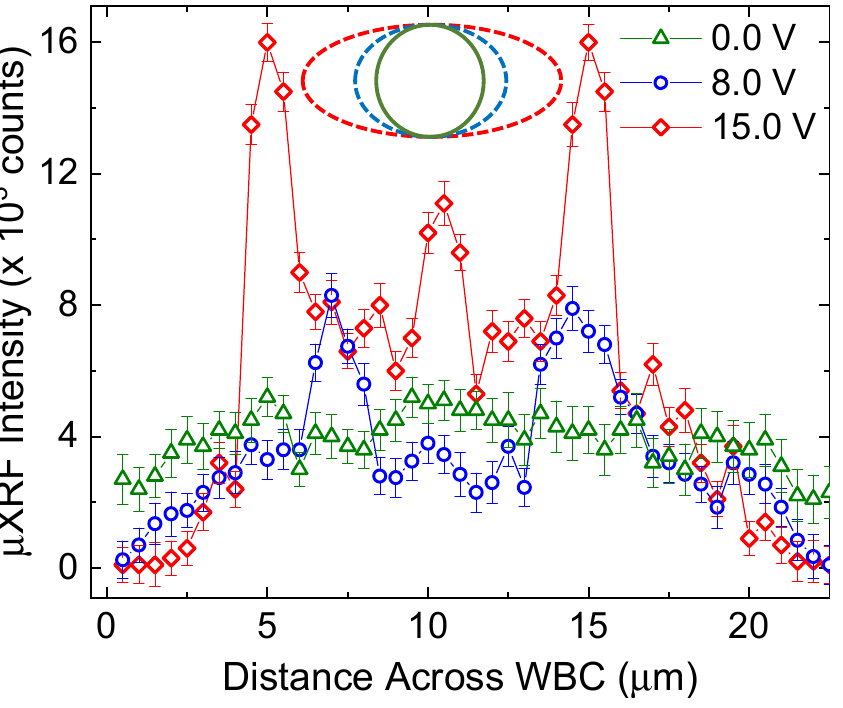
Figure 3. Micro-X-ray fluorescence scans performed while cell and gold nanoparticles are under the influence of an applied electric field. Zero voltage shows relatively evenly distributed AuNPs. As the voltage is increased, the cell is deformed, and the concentration of AuNPs in the membrane region is increased. The upper centered insert shows sketched deformation of the WBC (not to scale), under the assumption that the deformation is elliptical.